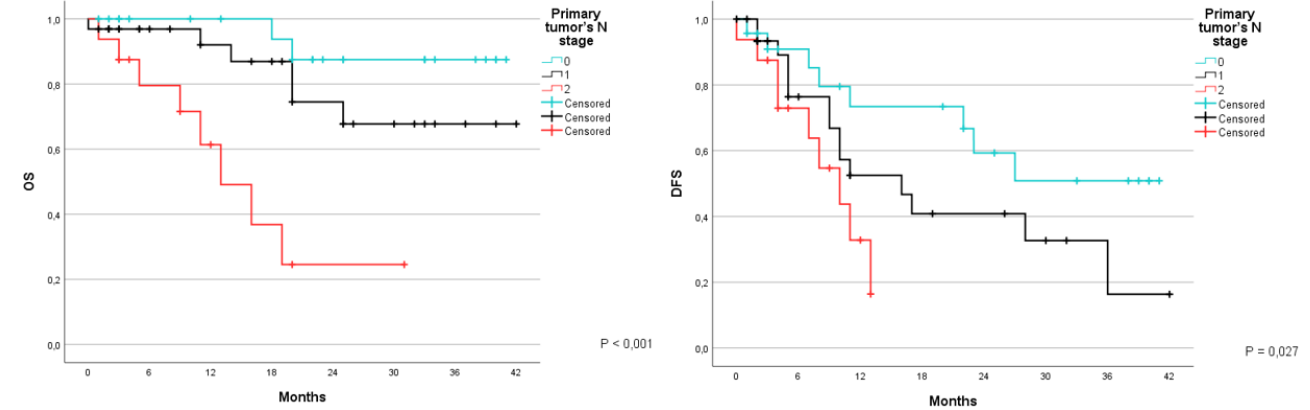
10 of 21 Figure 3. Kaplan-Meier Curve for OS and DFS in patients who underwent liver resection for CRLM stratified according to the primary tumor’s T stage. OS: Overall Survival; DFS: Disease Free Sur- vival; CRLM: Colorectal liver metastasis. Subsequently the same analyses were carried out with the N parameter. The overall survival at 1 and 3 years was 100% and 87.5% for patients with N0, with an average sur-